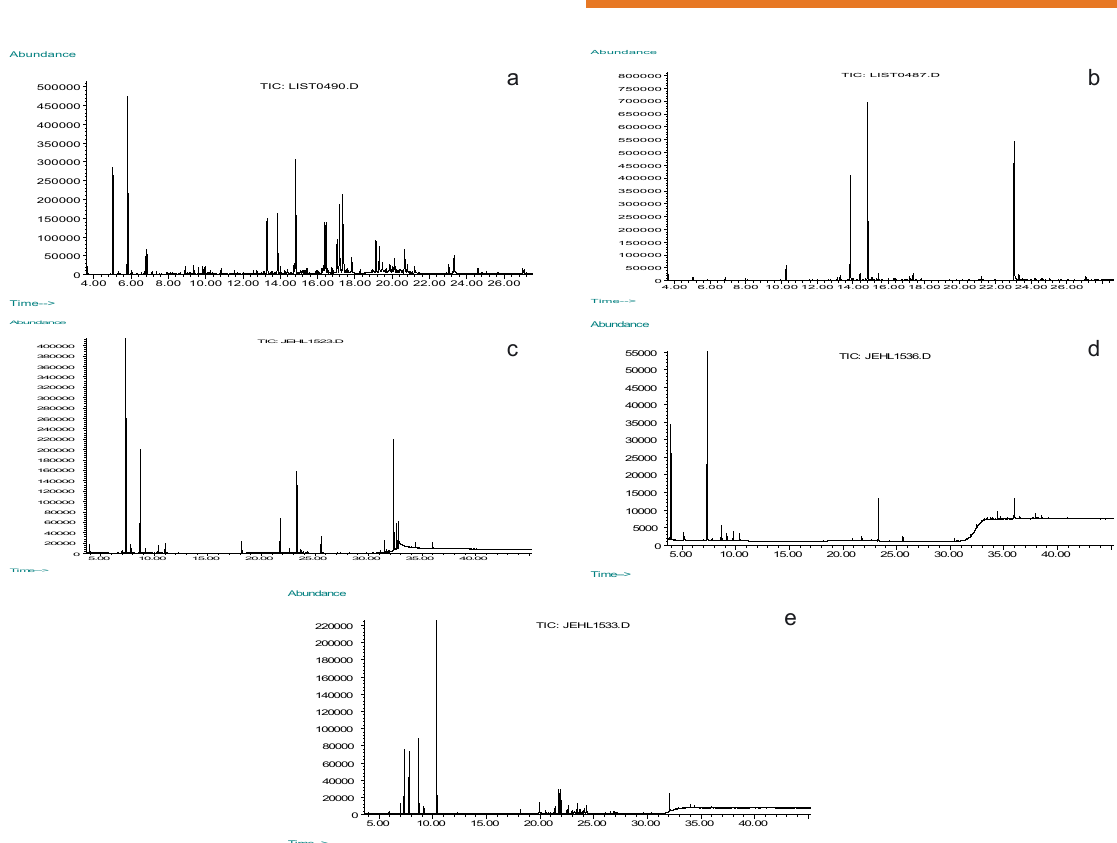
Figure 1. Chromatograms of extracts of J. regia L. (a), P. abies L. Karst. (b), Pinus nigra Arnold (c), Larix decidua Mill. (d), Abies alba Mill.